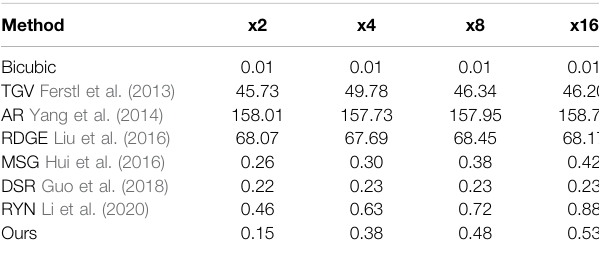
TABLE 6 | Average inference time (seconds) for different scaling factors.